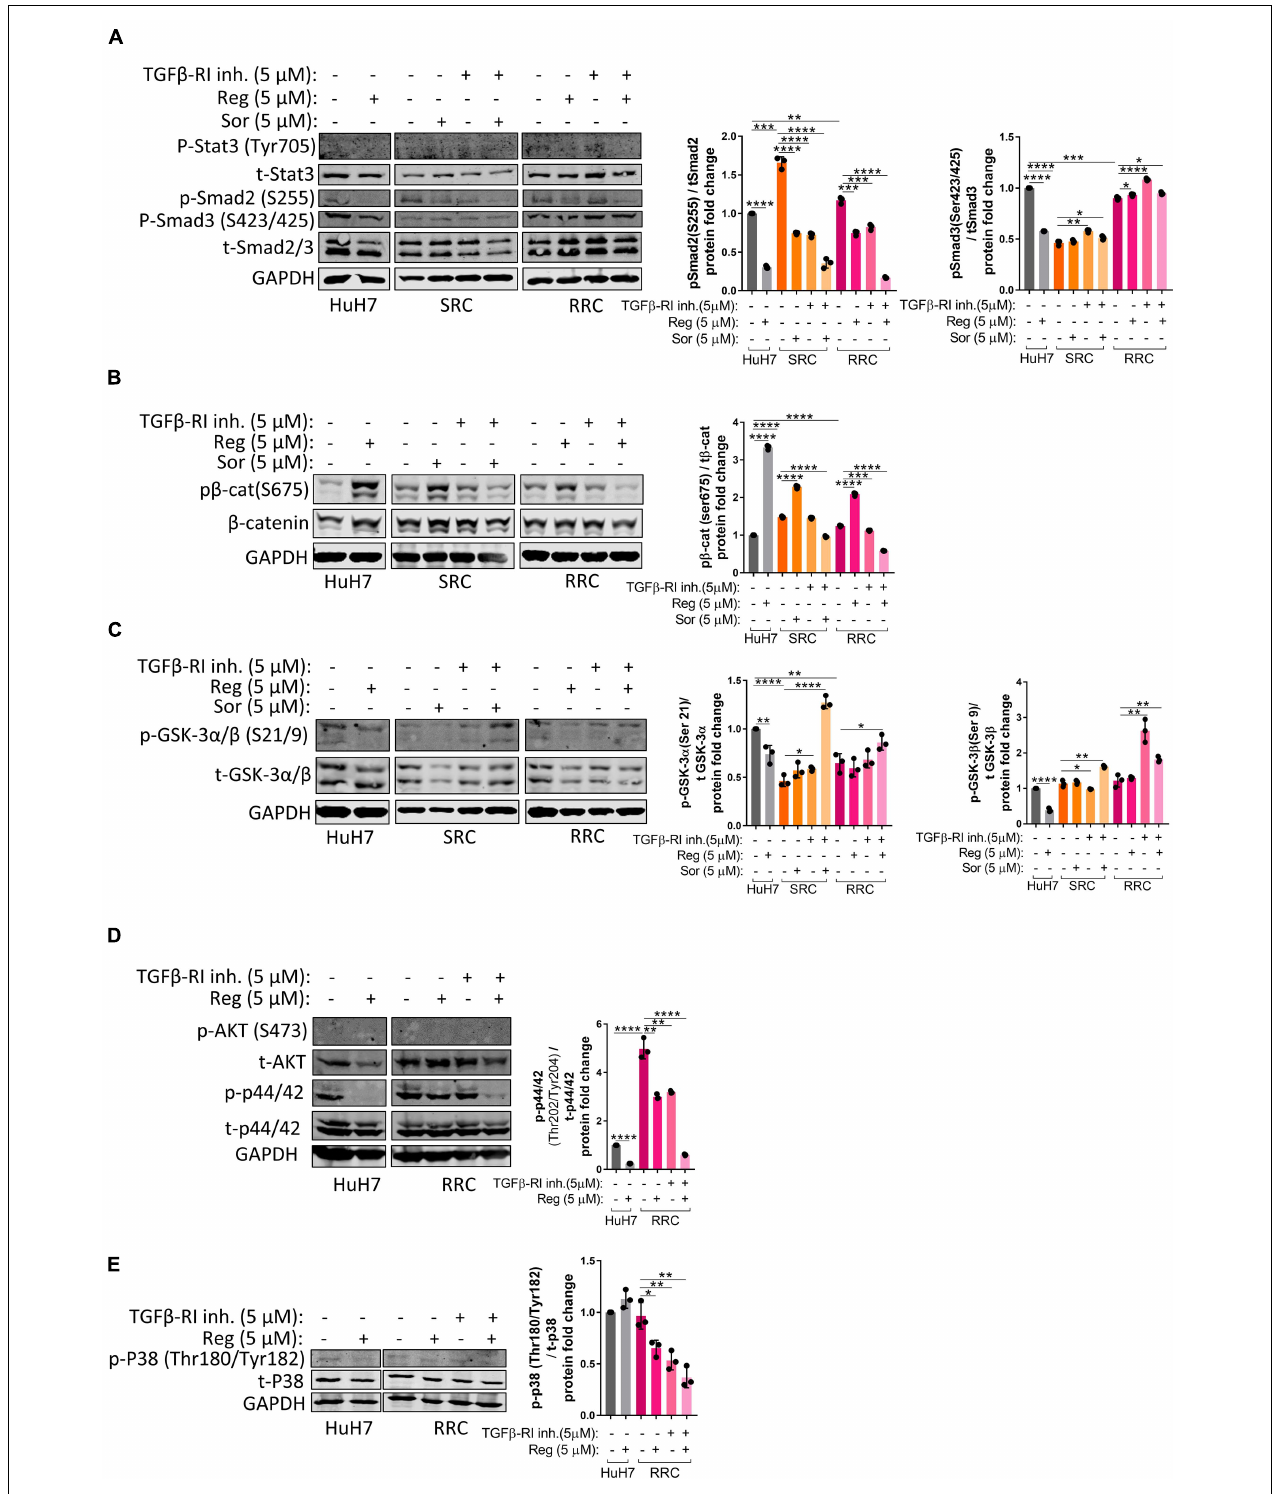
FIGURE 8 | Western blot analysis of resistant cells. (A–E) Western blot analysis of untreated and treated (sorafenib, regorafenib, TGF β -R1 or combined) parental HuH7, SRC and RRC cells. Bar graph represents the densitometric plot of protein expression in various groups. p > 0.05 (n.s.), p ≤ 0.05 (*), p ≤ 0.01 (**), p ≤ 0.001 (***), p ≤ 0.0001 (****). Error bars indicate standard deviation (SD).